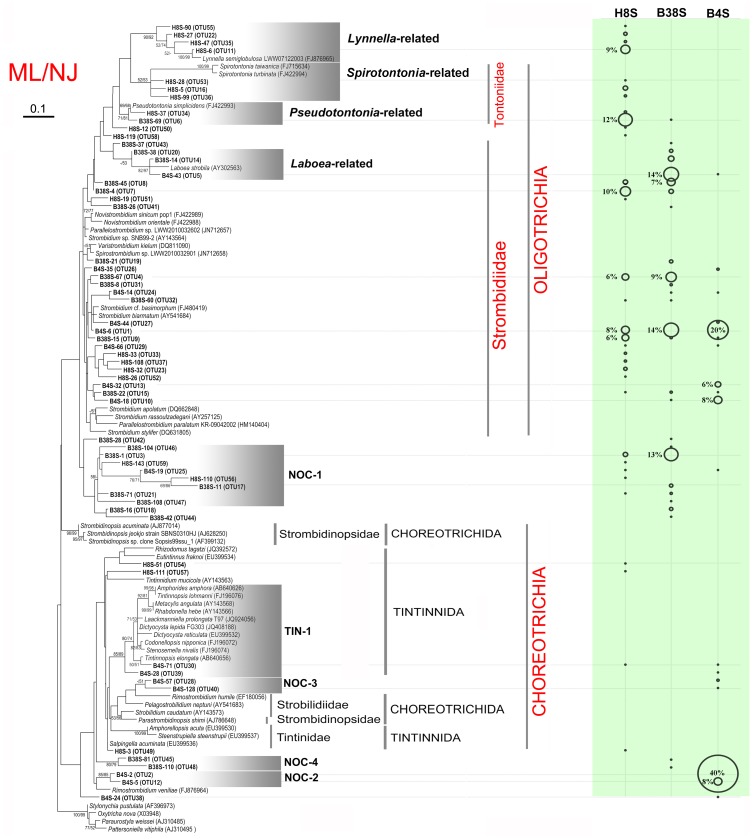
A consensus of maximum likelihood (ML) and neighbor-joining (NJ) phylogenetic trees based on 18S rRNA gene sequences.Showing the phylogenetic placements of representatives of operational taxonomic units and described species of oligotrich and choreotrichs. Sequences newly obtained in this study are in bold. Relative abundances of OTUs are indicated by circles of proprotional size on the right. Only bootstrap values no less than 50% are shown. Accession numbers are provided in brackets. The scale bar indicates ten nucleotide changes in 100 sites.